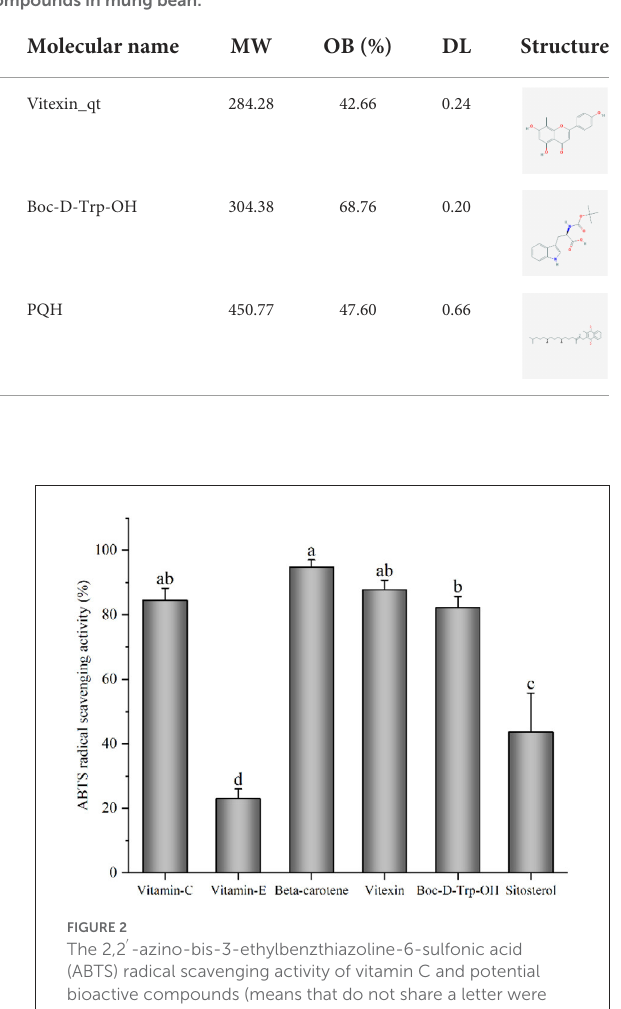
TABLE 1 Pharmacokinetic profiles and structure of potential bioactive compounds in mung bean.